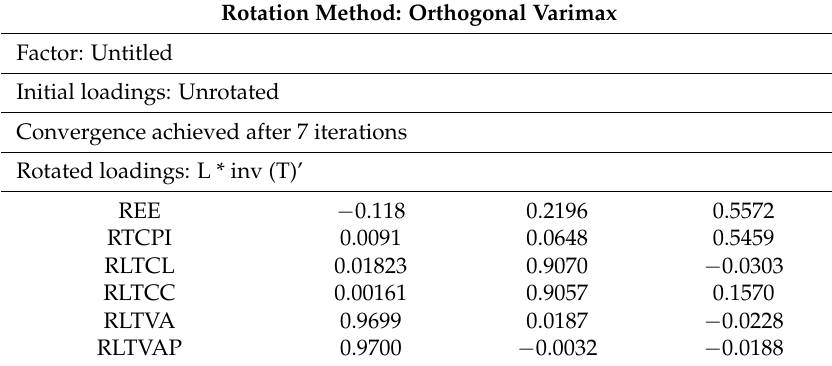
Rotation Method: Orthogonal